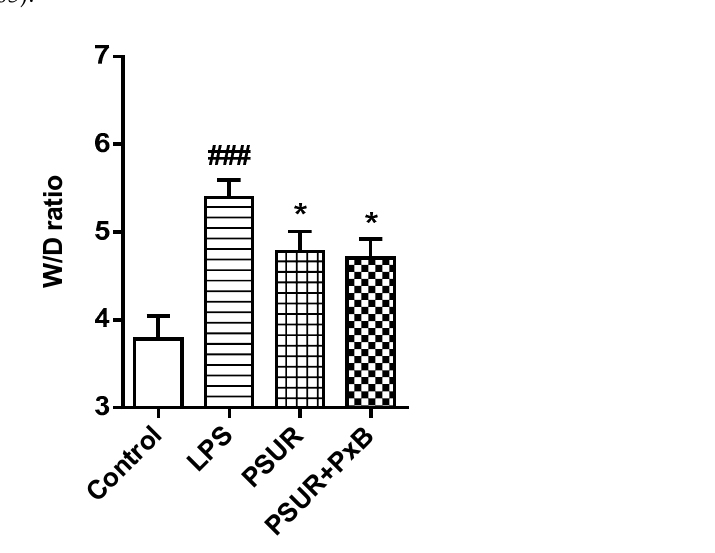
Figure 6. Lung oedema formation at the end of the experiment. Values represent W / D (wet / dry) weight ratio of lung tissue. Control vs. LPS ### p < 0.001, LPS vs. PSUR, LPS vs. PSUR + PxB, * p < 0.05.